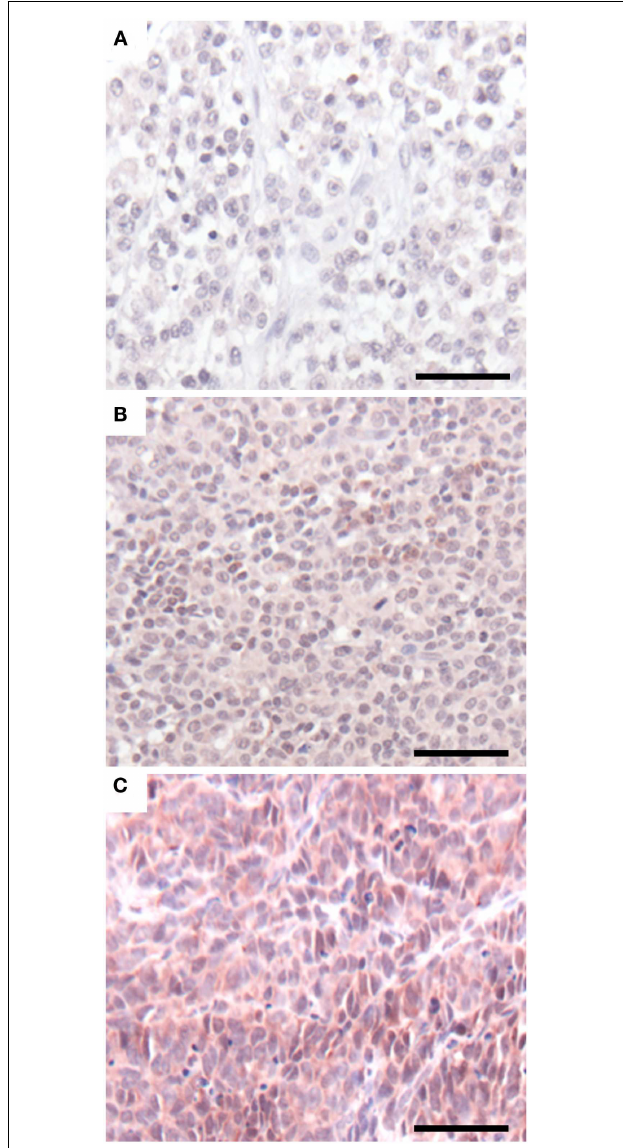
FIGURE 4 | GLIPR1 staining in malignant melanoma . GLIPR1 immuno-staining in (A) malignant melanoma of the heel ( + , low staining intensity), (B) malignant melanoma of the pate/crown ( ++ , moderate staining intensity), and (C) malignant melanoma of the thumb ( +++ , high staining intensity). GLIPR1 immuno-positive regions were stained with NovaRED. All images were photographed at a power of 200 × . Scale bar = 50 µ m. Samples shown are from Melanoma tissue microarrays (US Biomax, Inc.).